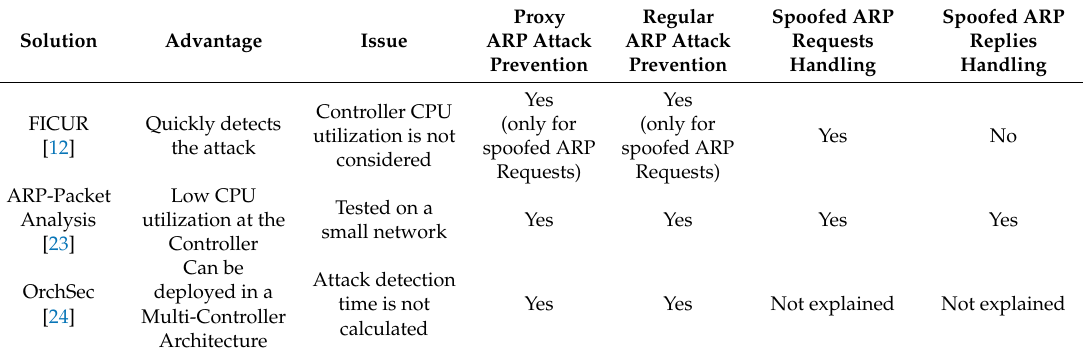
Table 1. Summary of Tra ffi c Patterns Based